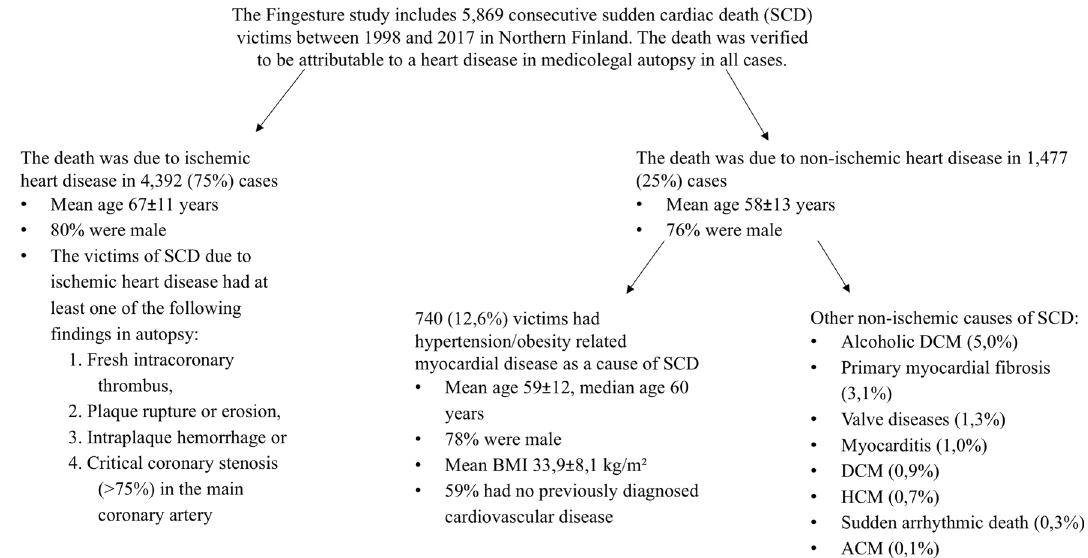
Figure 1. Description of autopsy findings in the Fingesture study. Continuous data is presented as mean ± standard deviation. ACM arrhythmogenic cardiomyopathy, BMI Body Mass Index, DCM dilated cardiomyopathy, HCM hypertrophic cardiomyopathy, SCD Sudden cardiac